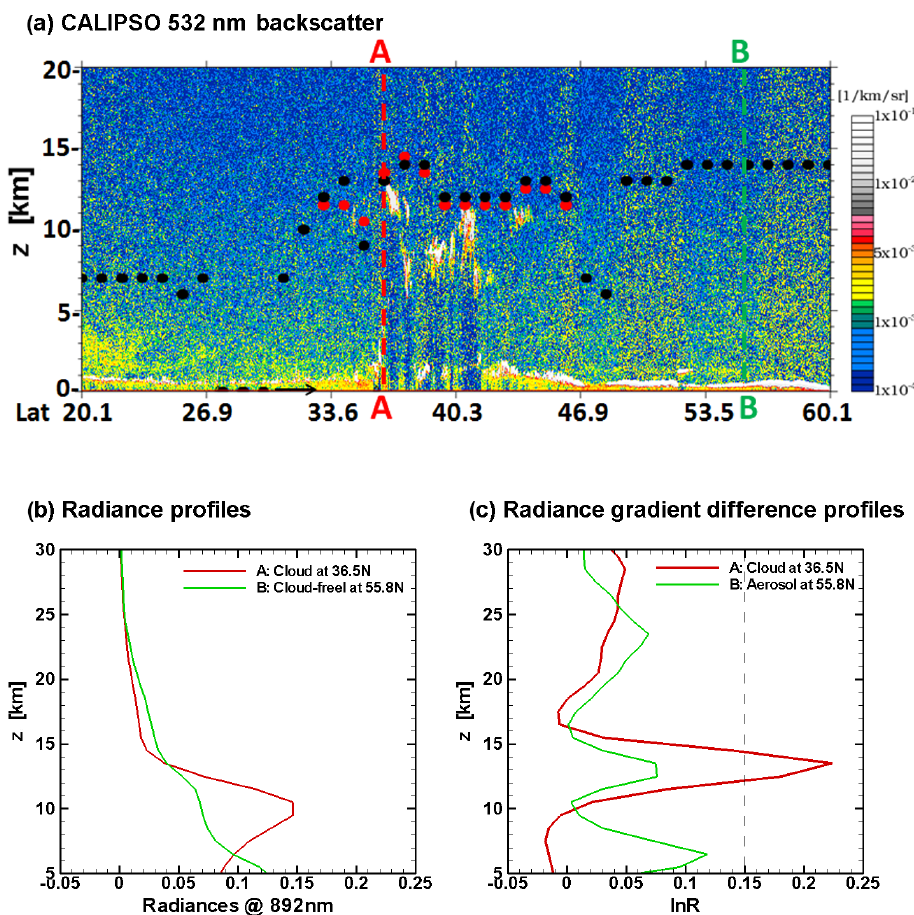
Figure 5. Comparison of LP cloud detection results for a single orbit on 16 August 2012. (a) CALIPSO 532nm daytime backscatter data for the same orbit. The red–gray–white regions in the image denote the cloud layers. The red and black dots in the image represent cloud-top heights derived from the LP radiance gradient algorithm and the LP Version 2 algorithm, respectively. Lines A and B indicate OMPS/LP measurements at 36.5 and 55.8 ◦ N, respectively. (b) Radiance profiles at 892 nm used as the basis for LP Version 2 algorithm cloud identification. Red: event A; green: event B. (c) Radiance gradient difference profiles used for new LP algorithm cloud identification. Red: event A; green: event B. The dashed line represents the value of the cloud detection